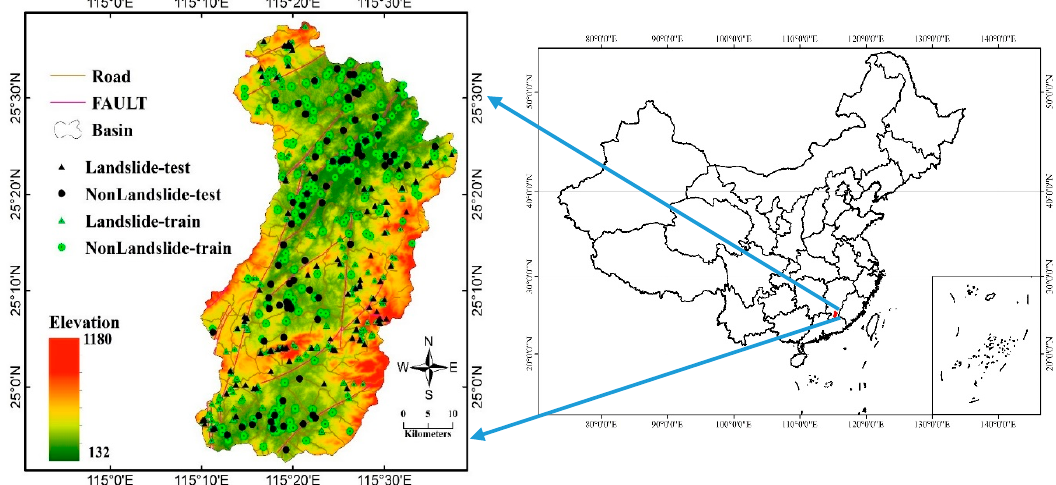
Figure 1. The study area and landslide locations.